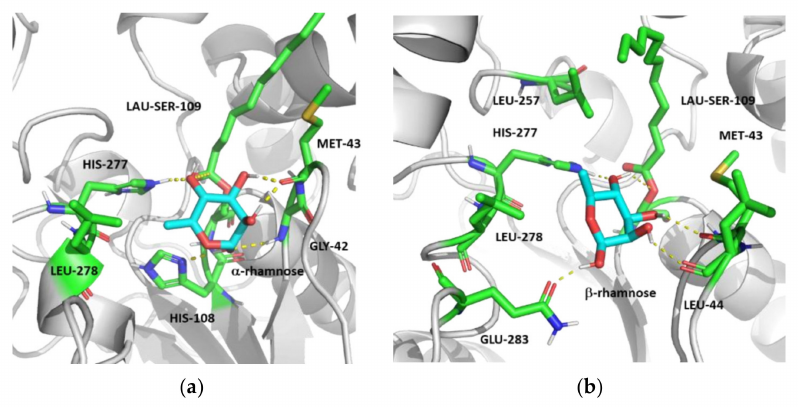
Figure 11. Three-dimensional view of the interaction after 50 ns of MD simulation between PSL and ( a ) α -rhamnose and ( b ) β -rhamnose. Enzyme is depicted in cartoon grey, principal residues of the enzyme are depicted in green sticks and sugars in cyan